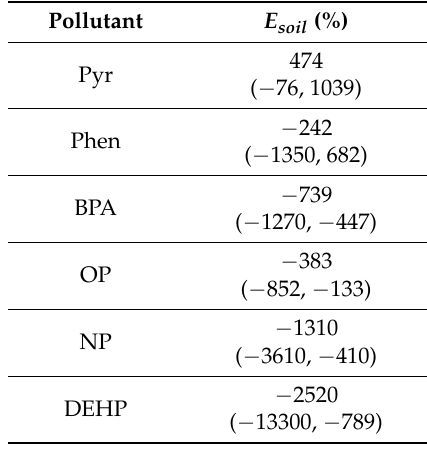
Table K1. Relative uncertainties (95% confidence interval) for all terms micropollutants, in percentage.